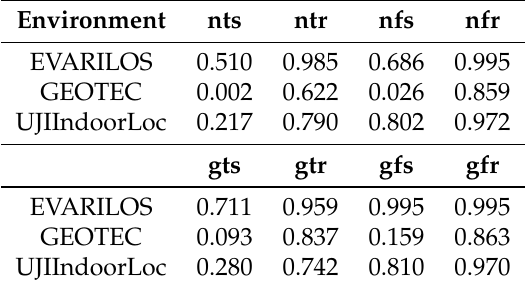
Table 6. Quality measures of the sensor model implementations in the different environments. The column labels refer to using the normal sensor model (n) or using the convolution sensor model (g), using the trained σ (t) or using the fixed σ (f) and using a single reference location for training (s) or using a region of reference locations for training (r).